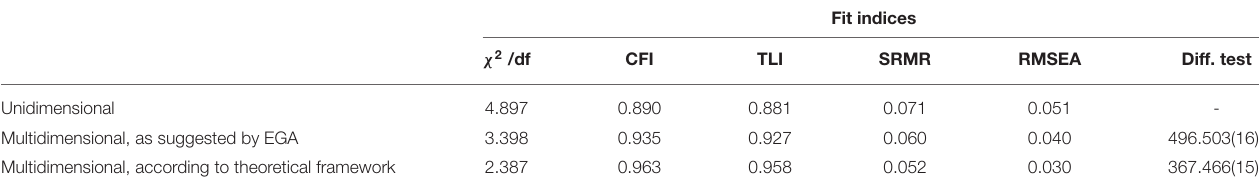
TABLE 3 | Goodness-of-fit indices for the item response theory analyses according to the tested